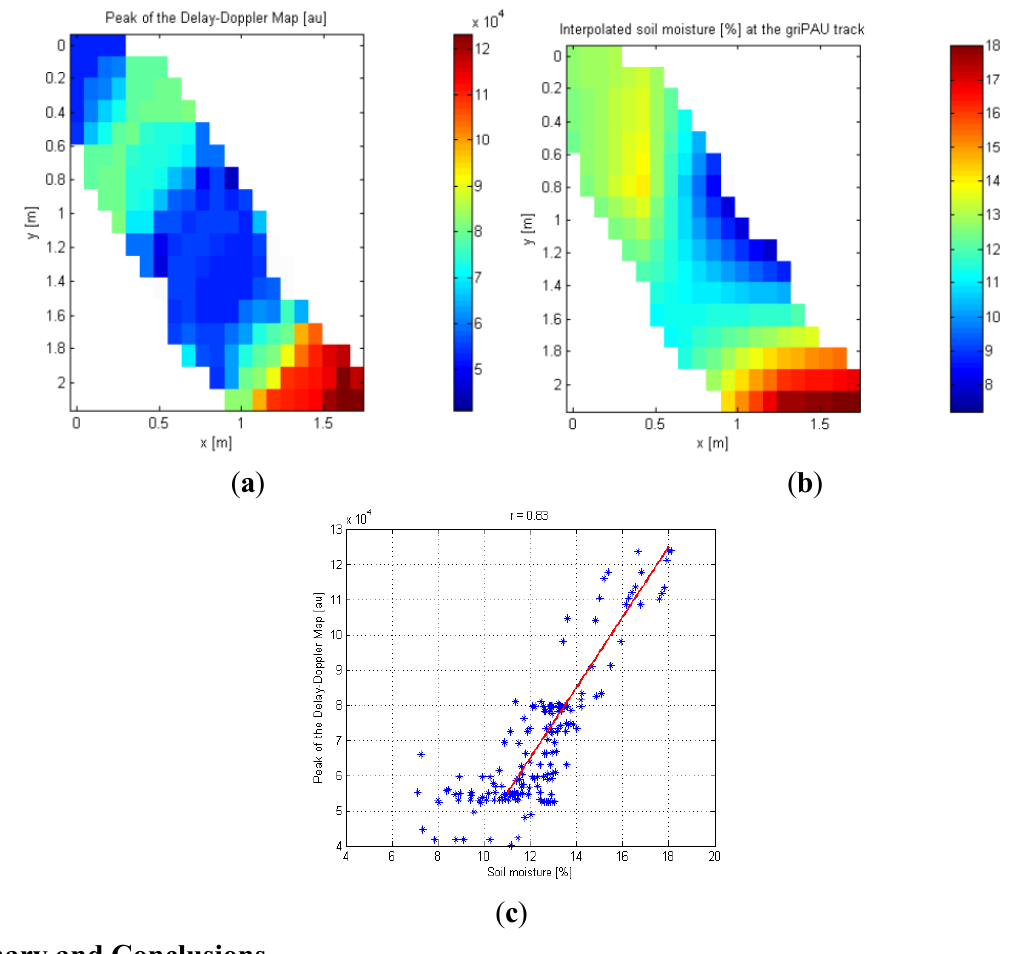
Figure 22. Geolocated ( a ) peak of the DDM during a satellite pass; and ( b ) points of the in situ measured soil moisture map; ( c ) Scatter plot between the in situ soil moisture values and the peak of the DDM showing a strong correlation ( r = 0.83). The trend is linear indicating that the peak of the DDM is proportional to the soil’s reflectivity, which is related to the soil moisture content (from